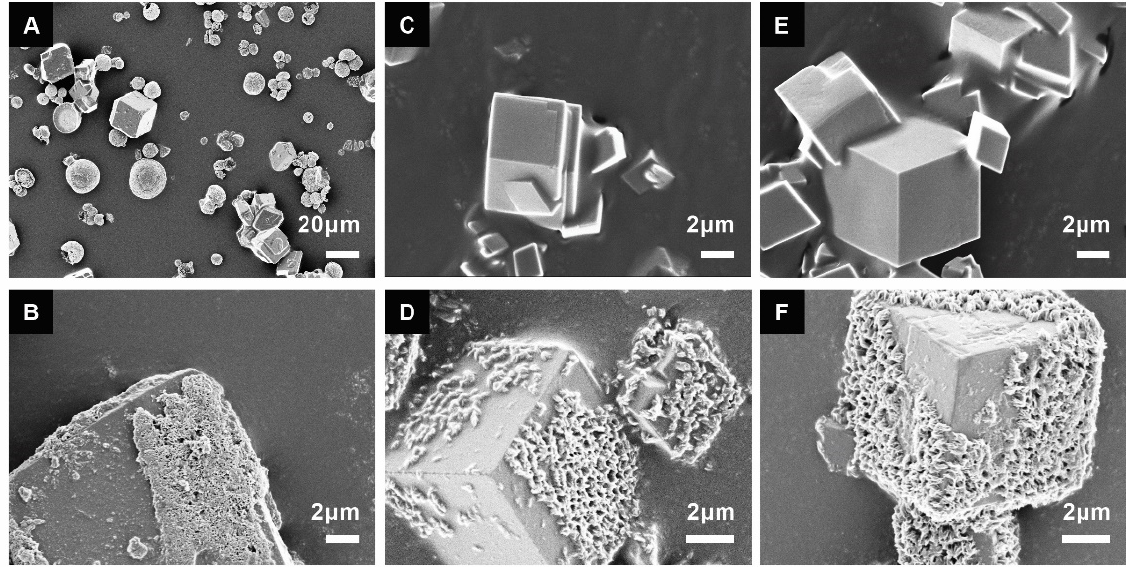
Figure 3. Calcite crystals with different concentrations of the drug before ( A , C , E ) and after two weeks in PBS solution ( B , D , F ); 0 mM hydroxyurea ( A , B ), 400 mM hydroxyurea ( C , D ), and 800 mM hydroxyurea ( E , F ). Hydroxyapatite was formed on the surface after two weeks in PBS for all formulations. In the non ‐ drug ‐ loaded calcite synthesis group, two phases were observed: the cubic ‐ shaped calcite and the spherical ‐ shaped vaterite ( A ).